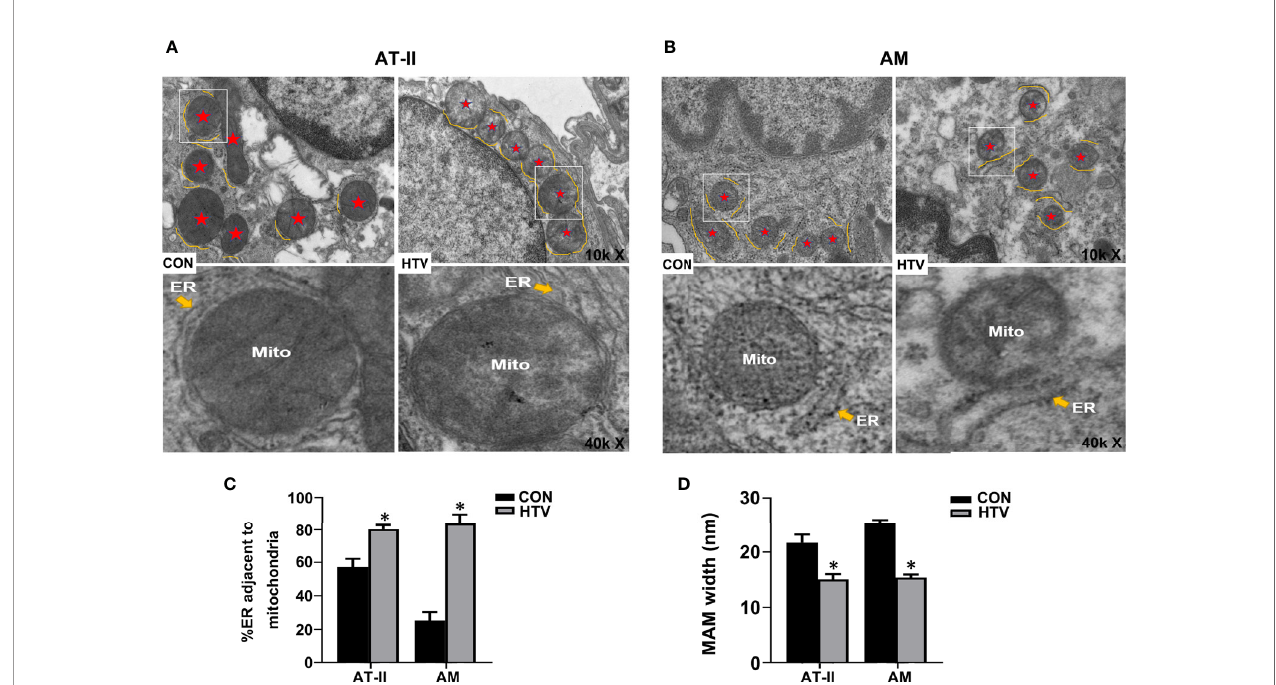
FIGURE 2 | MV with HTV induces MAM formation and changes in ER and mitochondrial morphology in lung cells. Representative TEM images of lung sections derived from group CON and HTV mice at ×10,000 (top images) or ×40,000 magni fi cations of the boxed areas (bottom images) in (A) alveolar type II epithelial cells (AT-II) and (B) alveolar macrophage (AM). The red stars indicate mitochondria, and the yellow curve indicate the ERs which around the mitochondria (Mito). (C) Quantitation of ER length adjacent to mitochondria normalized to total ER length. (D) Quantitation of width between ER and mitochondrial. Data are expressed as means ± SD (n = 3 per group), * P < 0.05 vs . CON